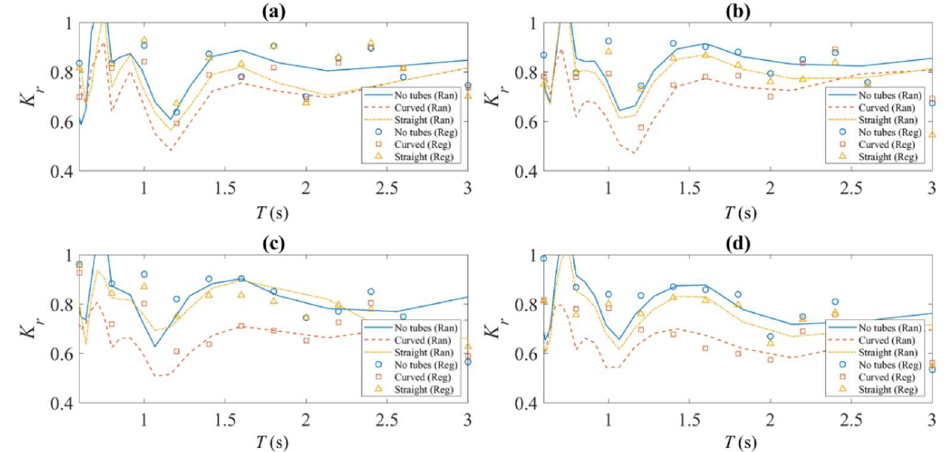
Figure 6. Reflection coefficients for various drafts ( a ) d = 0.42 m; ( b ) d = 0.37 m; ( c ) d = 0.32 m; ( d ) d = 0.27 m for a given wave height H = 0.06 m.